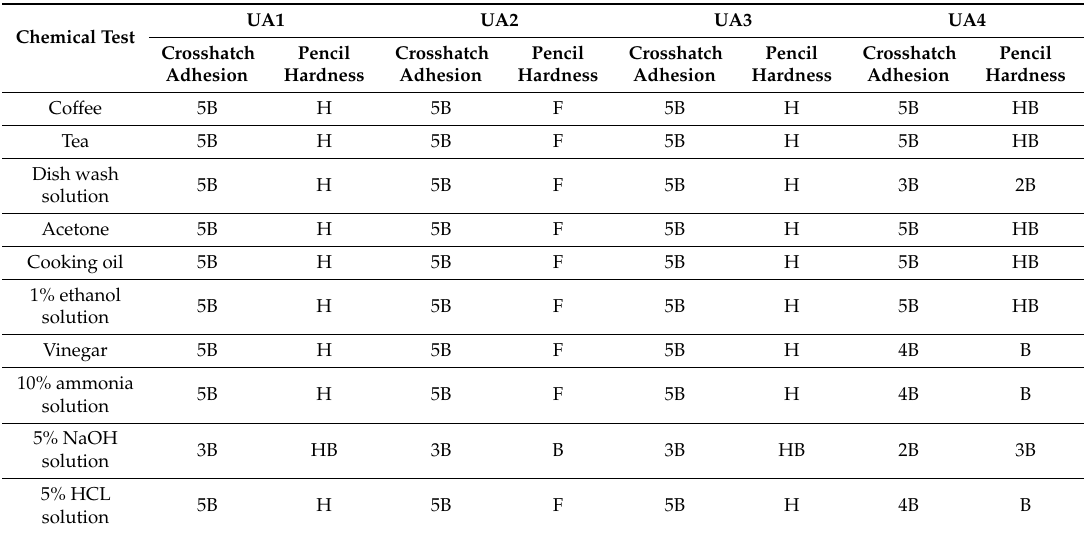
Table 9. Properties of the cured films of the UA, after 24 h chemical